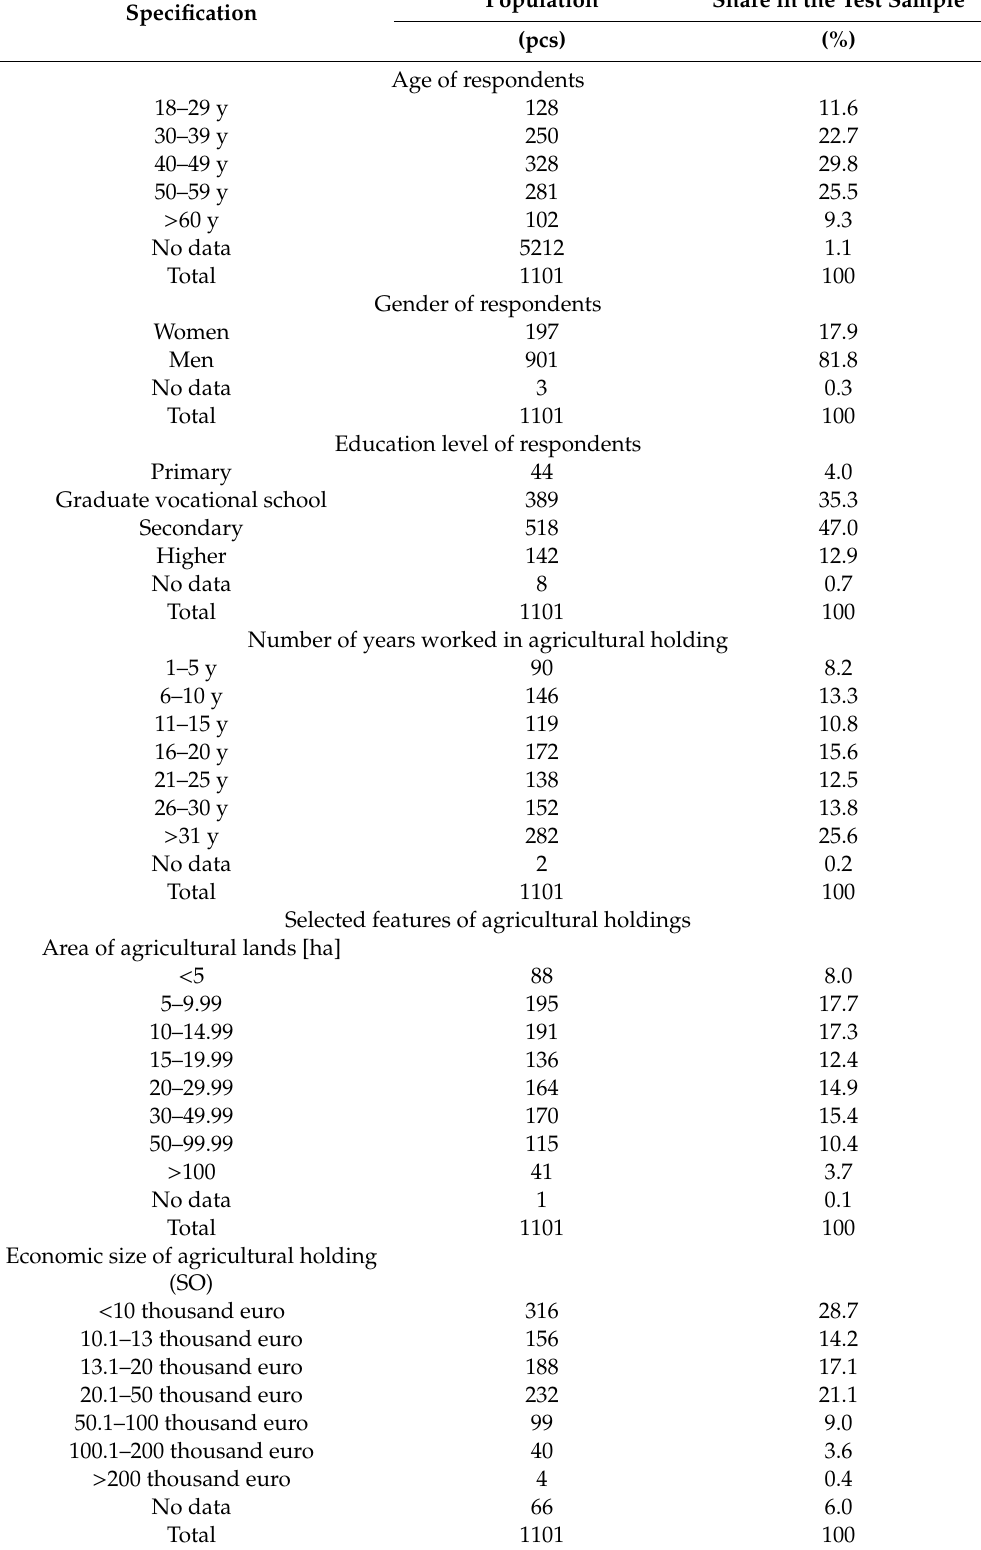
Table 2. General characteristics of the test